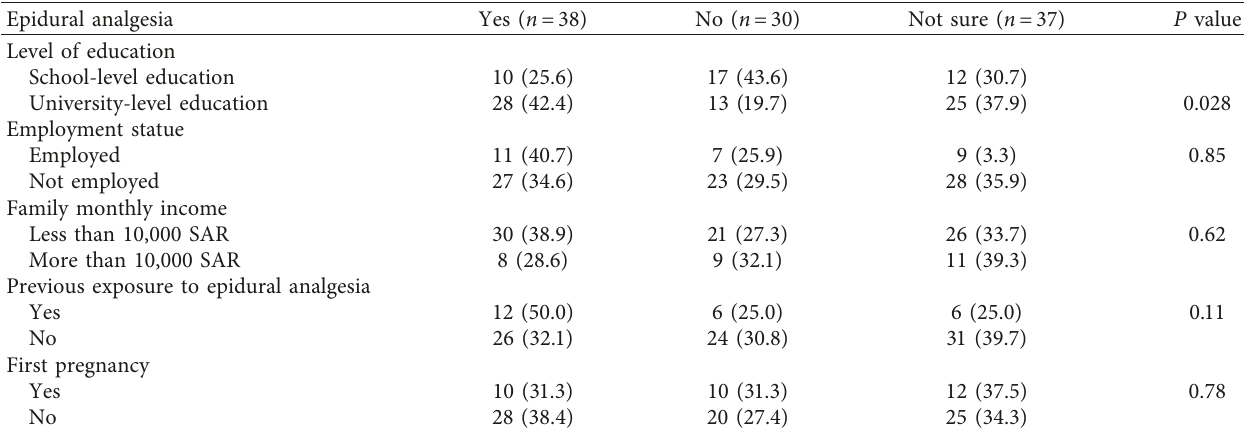
Table 3: Demographic characteristics and desire to receive epidural